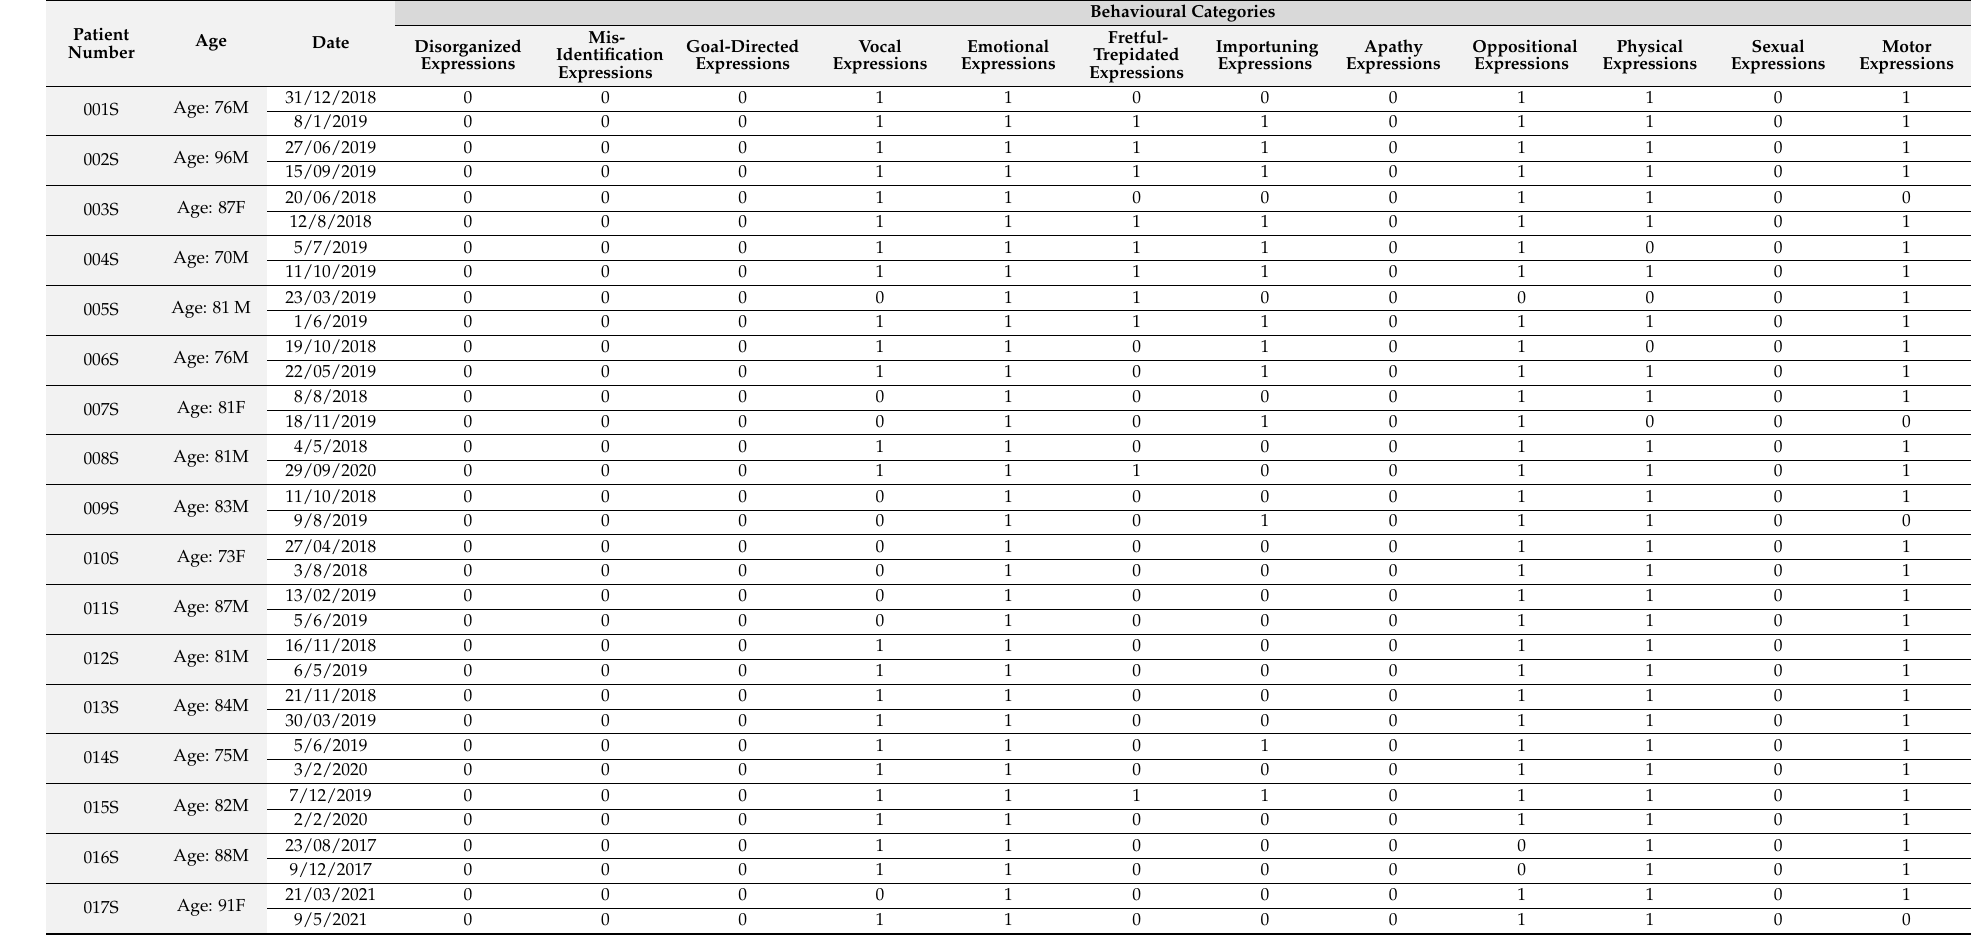
Table 2. Individual Demographics and Behavioral Categories in the Successful de-prescribed group. Columns show the individual patient’s demographics of identification number, age, and the initial and the second date of data collection. Rows show the individual behavioral categories with 0 representing the absence of the category and 1 representing the presence of the